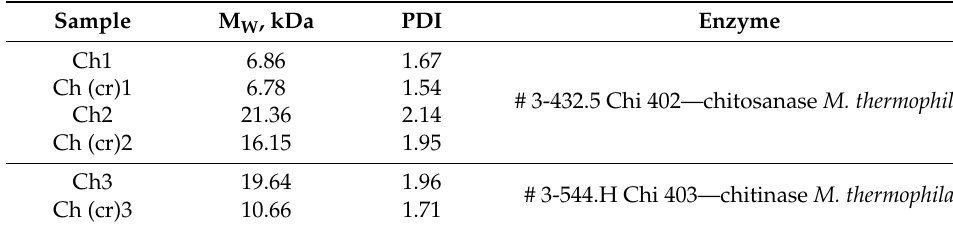
Table 4. Substrates used in the